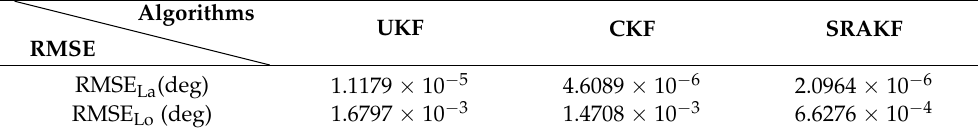
Table 4. RMSE for different